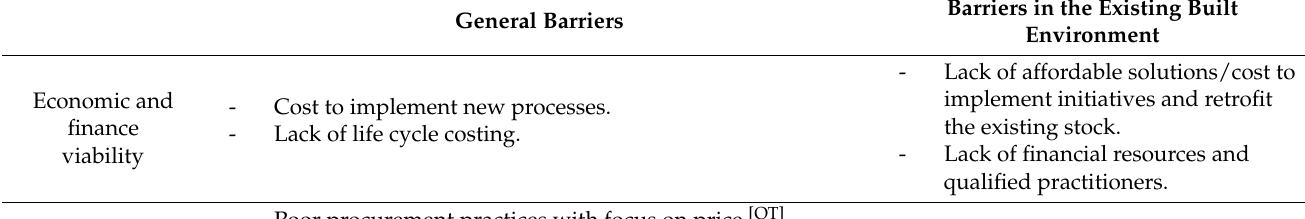
Table 3. Barriers for regenerative and circular practices identified in interviews. General